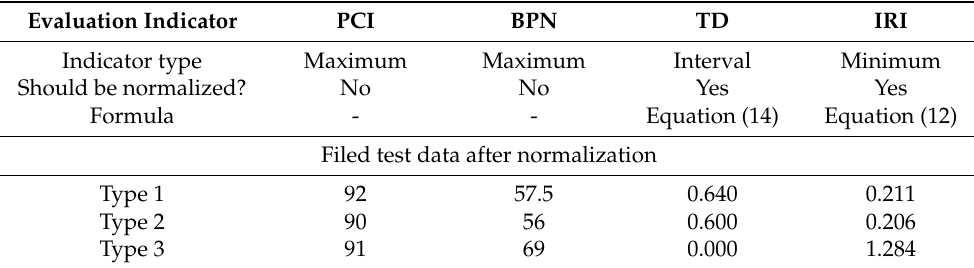
Table 10. Raw field test data before TOPSIS.